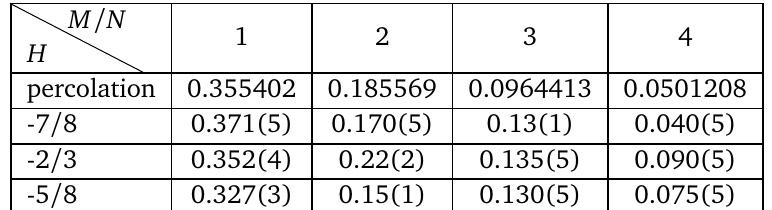
Table 2: Best fit parameter c ν ( M / N ) , for different aspect ratios M / N . These val- ues were obtained with the surface (52), which showed better convergence. When H > − 1 / 2, the non-universal effects are too strong and are not described by the fit